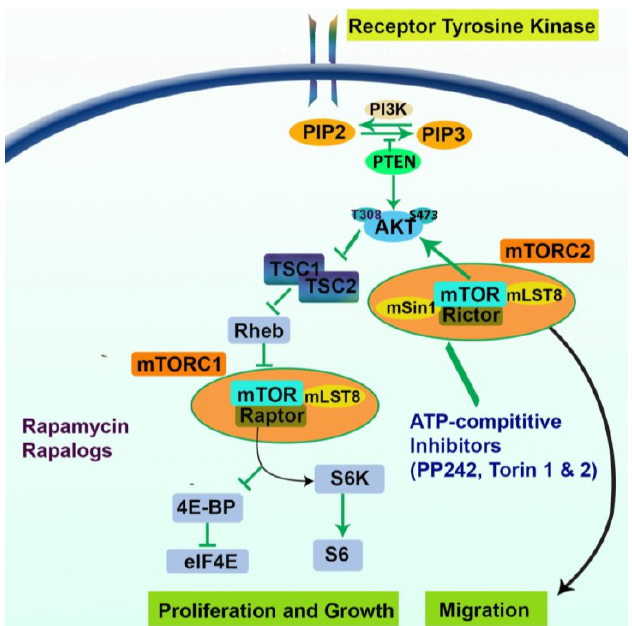
Figure 1. The PI3K/AKT/mTOR pathway in GBM. The inhibitors of this pathway